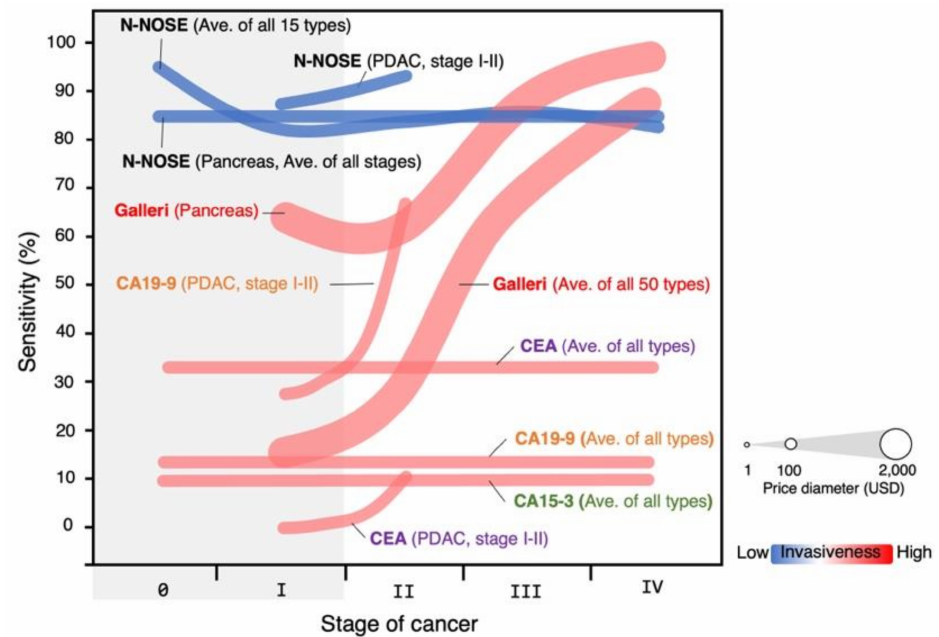
Figure 2. Comparison in sensitivity between N-NOSE and the other existing cancer screening kits. The diameter indicates the price (USD) of the kit. The color heat map indicates the invasiveness of the kit. N-NOSE is a less expensive and non-invasive screening kit with remarkable sensitivity for early-stage (0-I)